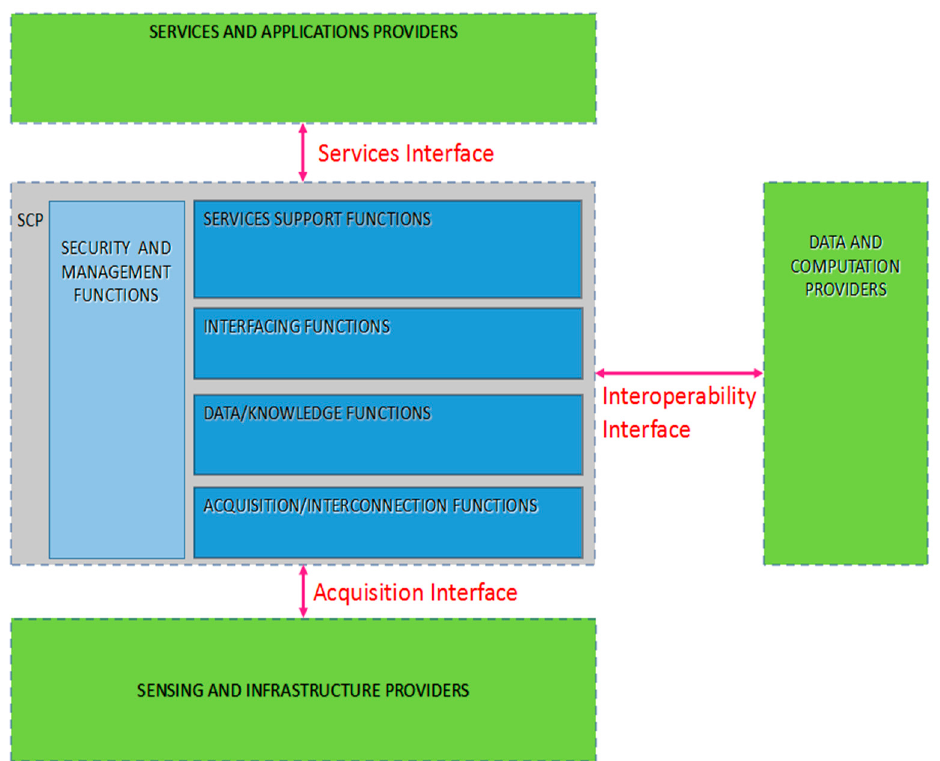
Figure 2. Reference framework of SCP.